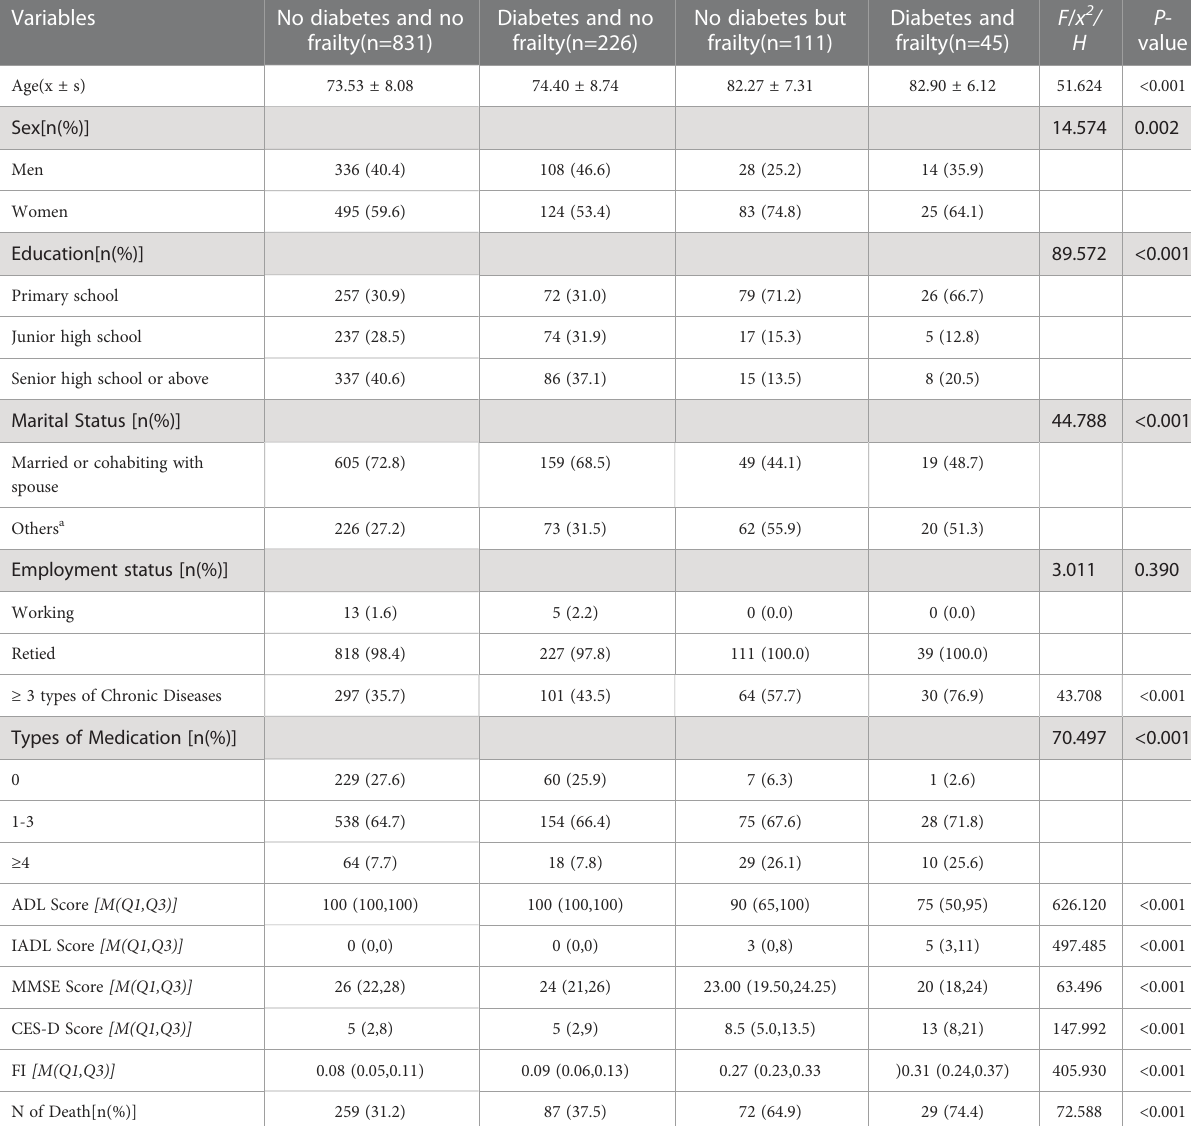
TABLE 1 Comparision of characteristics of the sample as separated by different status of diabetes and